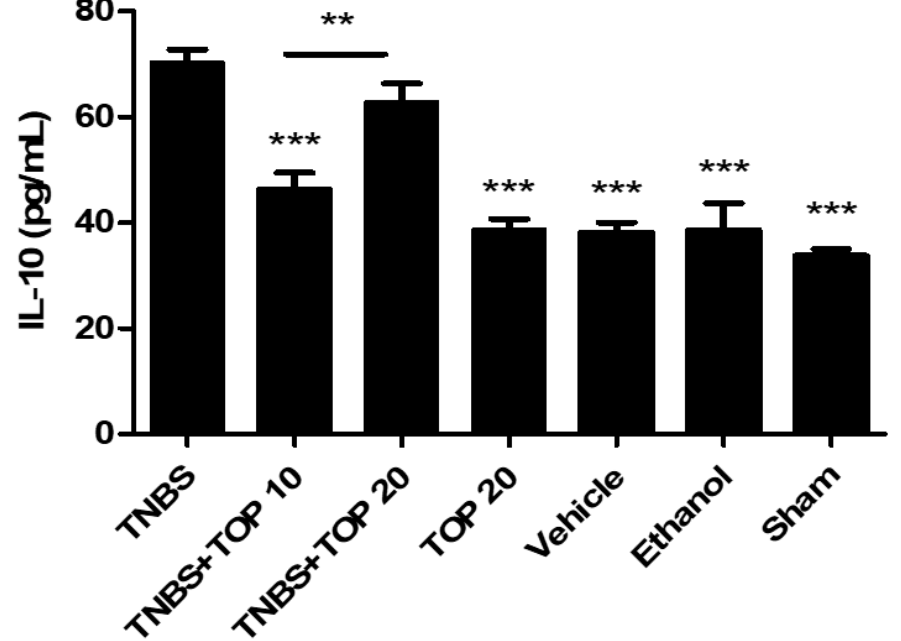
Figure 6. Effect of topiramate treatment on IL-10 concentration. Legend: one-way ANOVA and Tukey’s post-hoc test, ** p < 0.001 comparing TNBS + TOP10 group with the TNBS + TOP20 group; *** p < 0.0001 compared with the TNBS group.